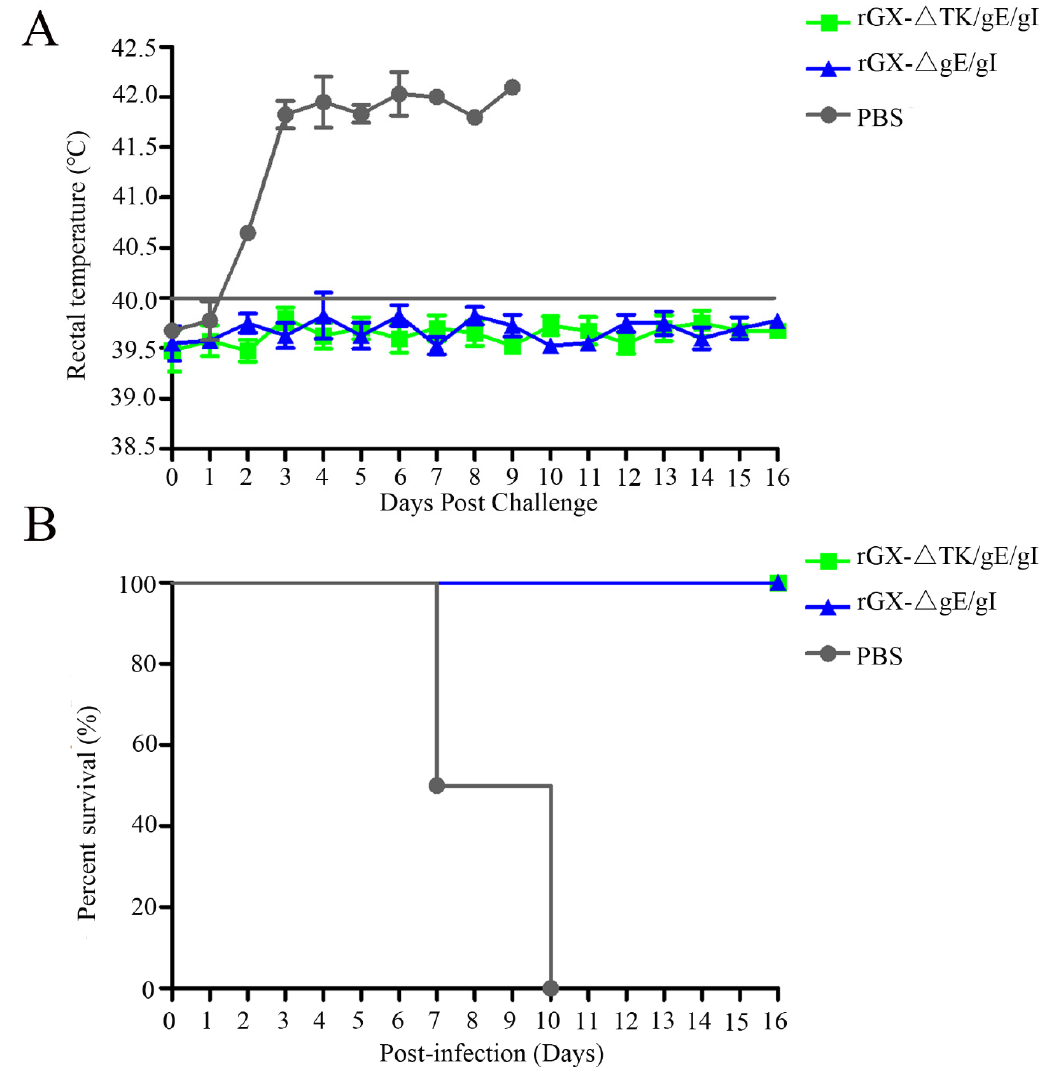
Figure 6. The effect of rGX Δ gE/gI and rGX Δ TK/gE/gI on rectal temperature and survival rates in pigs after challenge. Pigs were challenged with virulent PRV GX strain (10 7 TCID50) at 49 dpi, then ( A ) rectal temperature was recorded and ( B ) survival rates were calculated. Rectal temperature ≥ 40.0 °C was fever. n = 4. Table 3. Disease outcome in pigs inoculated following challenge with the highly virulent strain PRV-GX.